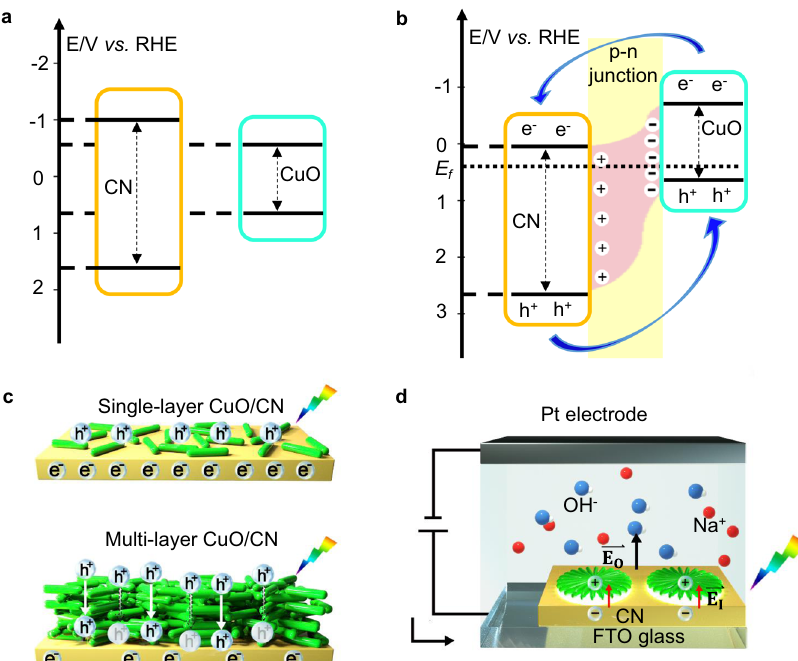
Fig. 6 Energy diagrams of the materials and charge transport properties. a Energy diagram of CN (carbon nitride) and CuO. b Energy diagram of the CuO/CN heterostructure, when CuO and carbon nitride are in direct contact. c Transport of photogenerated charges in thin-layer and multi-layer CuO/CN electrodes. d Star-shaped CuO on CN functions as a photoanode under light irradiation and applied potential. RHE reversible hydrogen electrode, E f energy of Fermi-level, ~ E I internal electric fi led, ~ E O applied electric fi